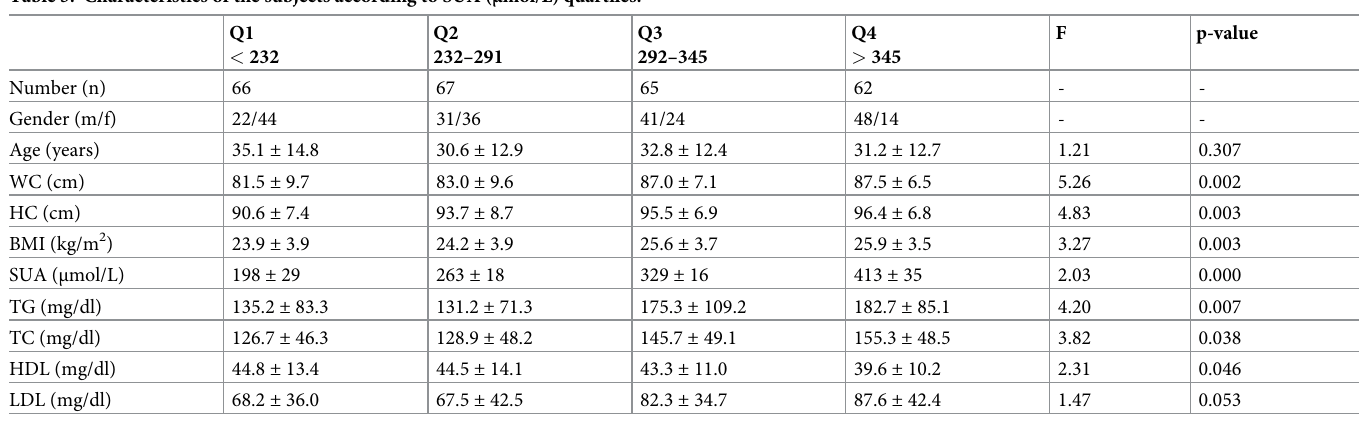
Values are presented as mean ± SD. P-values are obtained from one-way ANOVA.